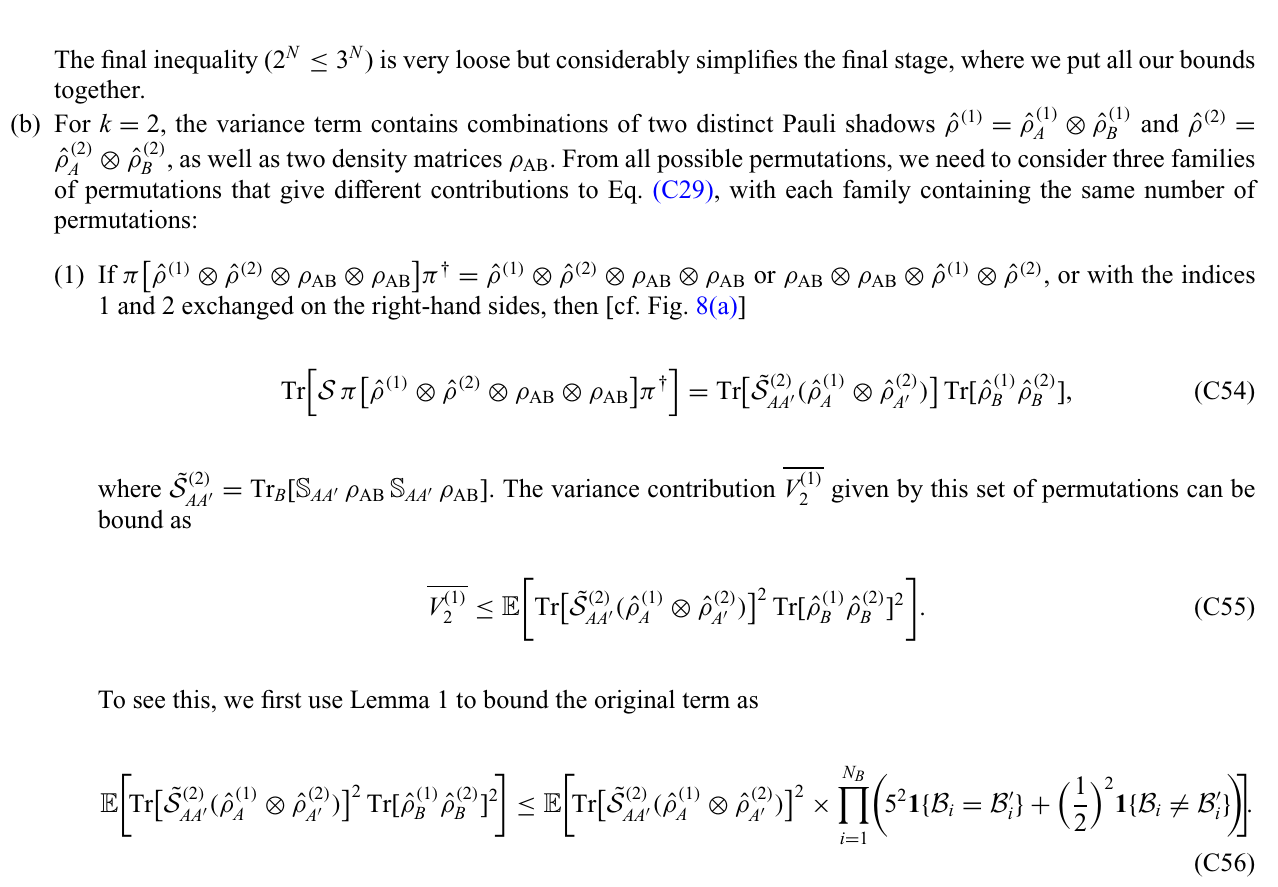
FIG. 7. The graphical representation for the case k = 1. (a) A diagrammatic expression of Tr easily seen that the expression is invariant with respect to any position of the shadow ˆ ρ ( 1 ) . (b) The operator in the dashed rectangle) that acts on ˆ ρ ( 1 )